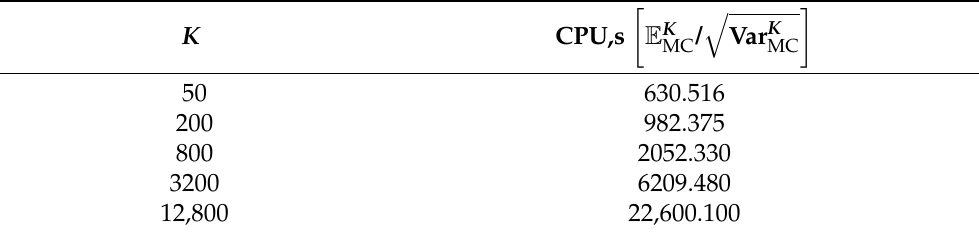
(cid:113) Var K in Table 1, for a fixed time horizon T = 1 and the step-sizes MC